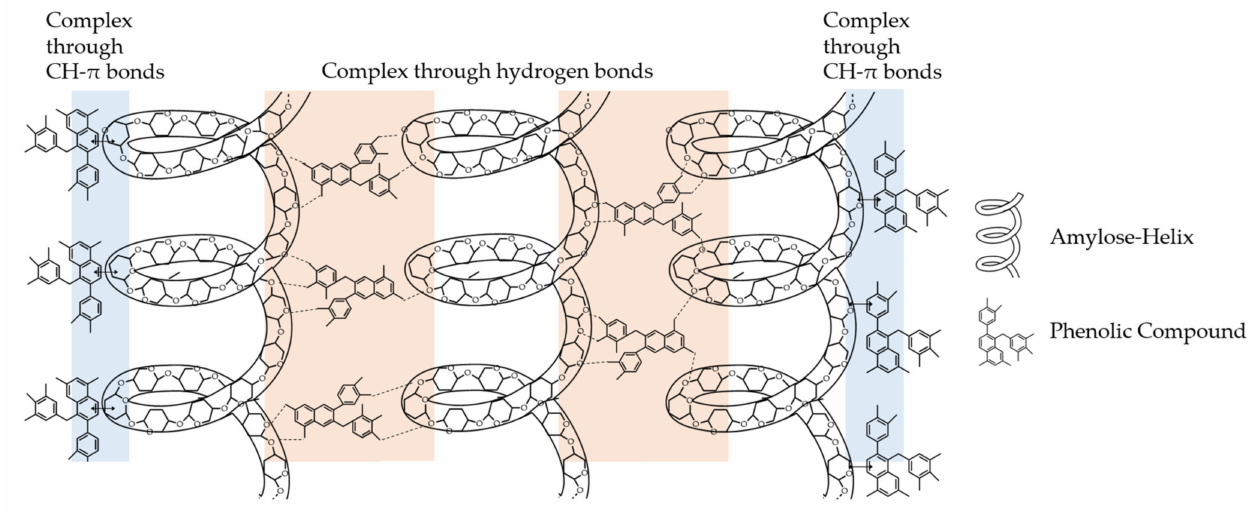
Figure 9. The model of non-inclusive complexes according to Guo et al.